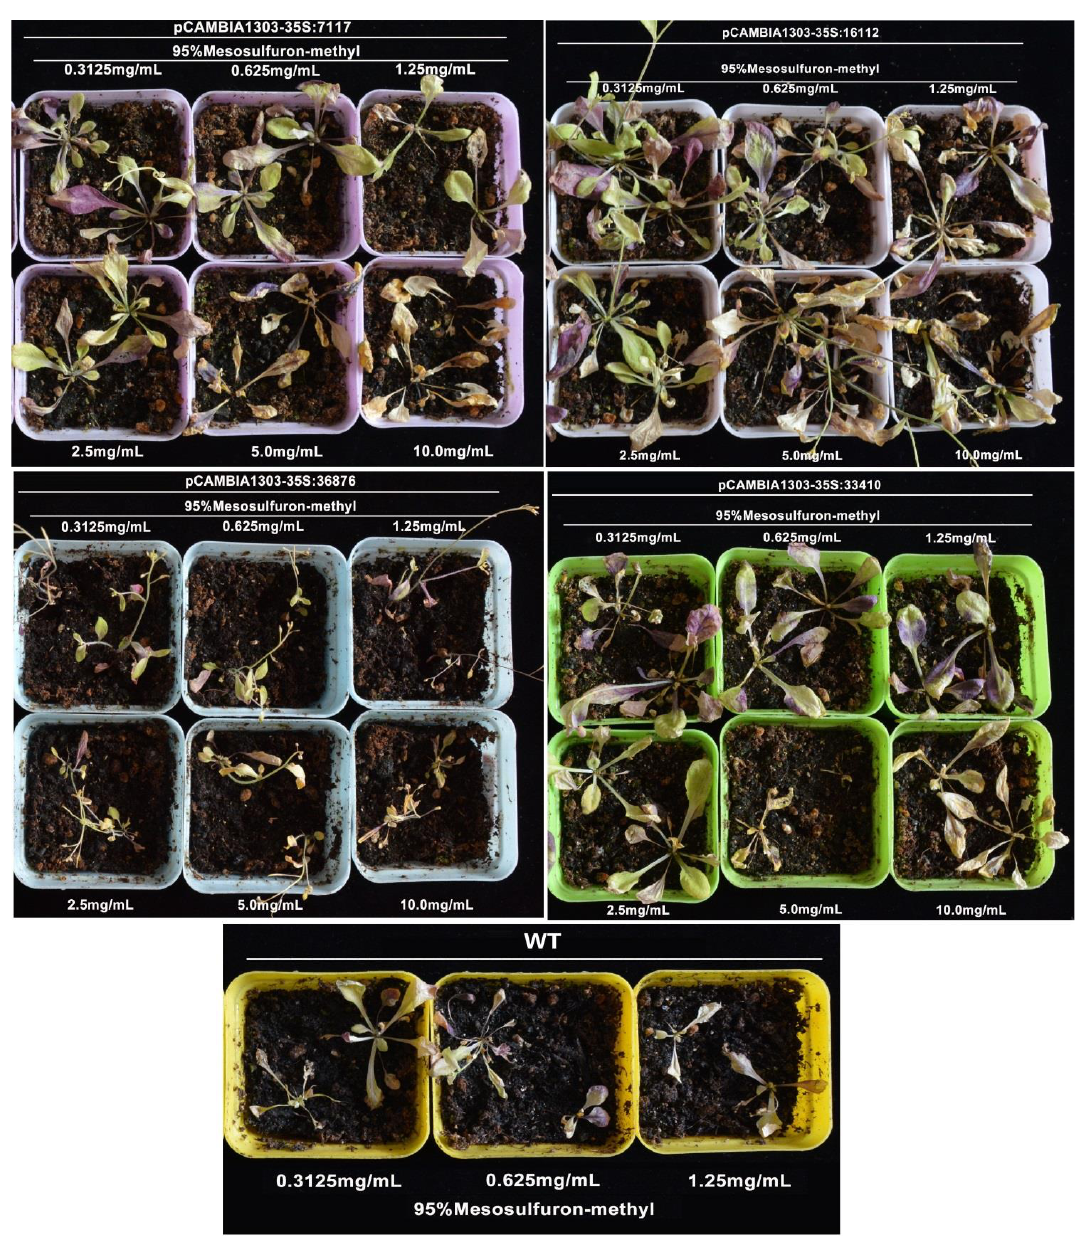
Figure 6. Biological phenotypic changes of Arabidopsis transgenic plants after application of different concentrations of Mesosulfuron-methyl at 7d. WT, wild-type.